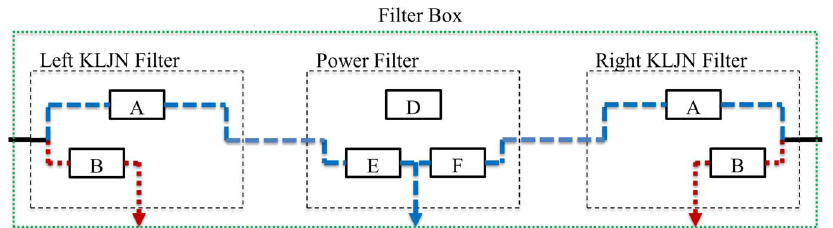
Figure 6. The filter box of the active host (when it is executing a KLJN key exchange): State 2. The power is passing between left and right but the KLJN band is not and the left and right KLJN units are separated while doing a key exchange toward left and right. State 1 is when the host is not allowed to access KLJN band. State 2 is when the host is allowed to access KLJN band. This filter box is in State 2.